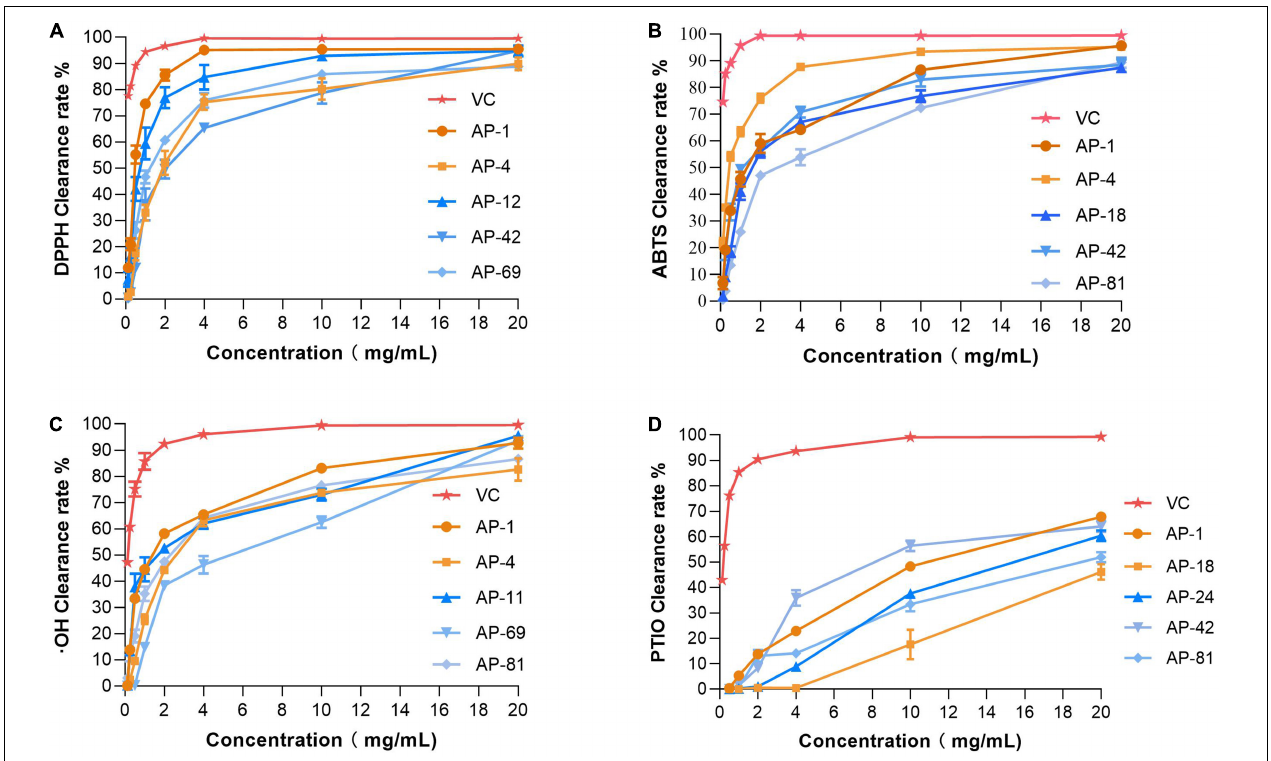
FIGURE 4 | Antioxidant activities of different concentrations of EXEs. (A) DPPH radical scavenging activity. (B) ABTS radical scavenging activity. (C) Hydroxyl radical scavenging activity. (D) PTIO radical scavenging activity.